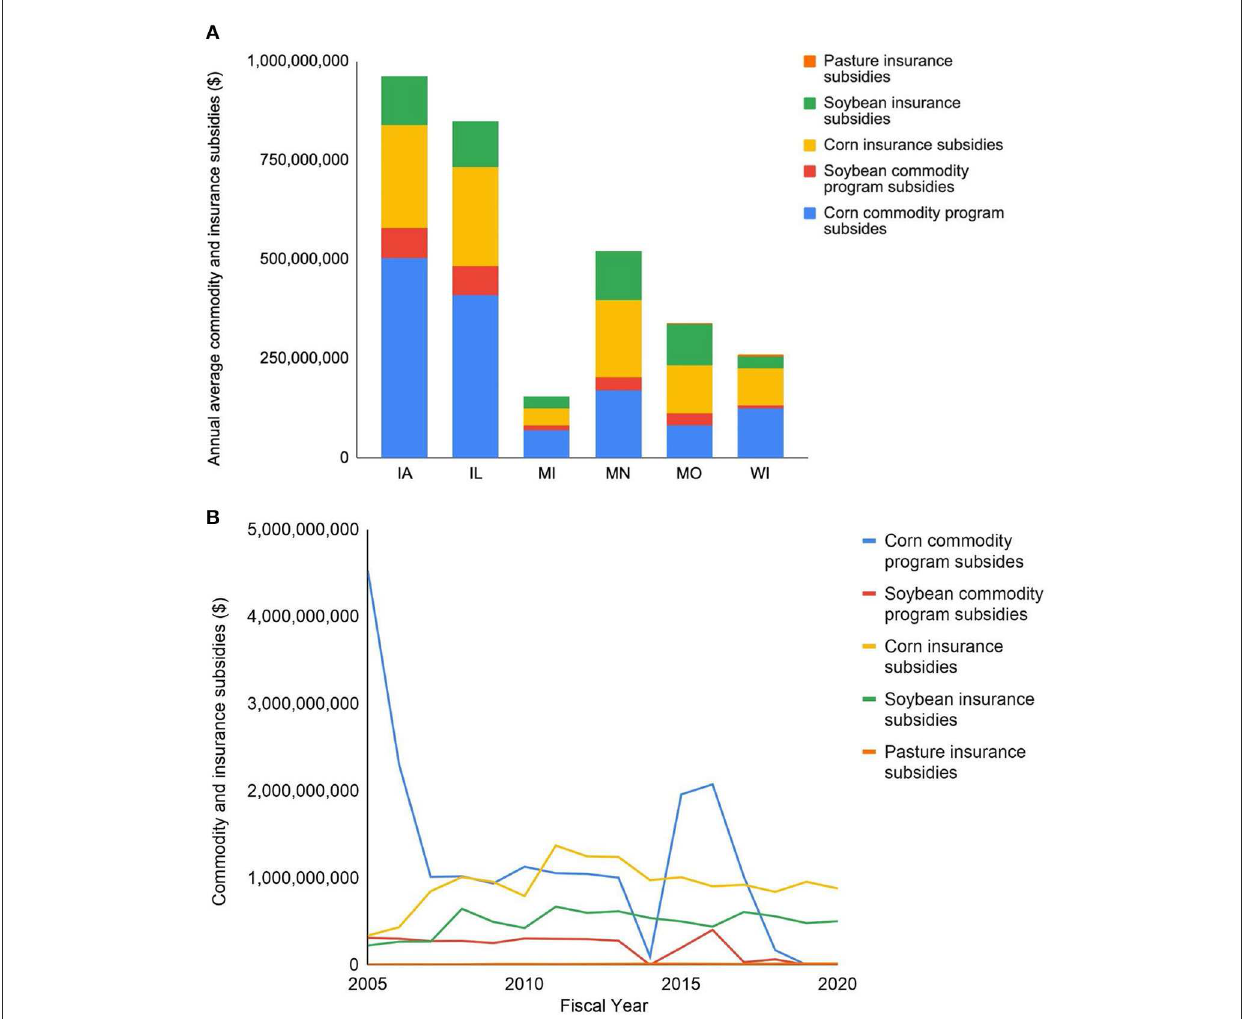
FIGURE2 (A) Annual average commodity and insurance subsidies per year in Iowa, Illinois, Michigan, Minnesota, Missouri, and Wisconsin ($). Annual average is between 2005 and 2021 for insurance (17 years) or 2005–2018 for subsidies (14 years). (B) Subsidies by USDA commodity and insurance programs in lowa, Illinois, Michigan, Minnesota, Missouri, and Wisconsin ($). Data source: Commodity subsidy data is from Environmental Working Group (Environmental Working Group, 2020a,b), including Direct Payments (DP) and Production Flexibility Contract (PFC) (1996–2013), Average